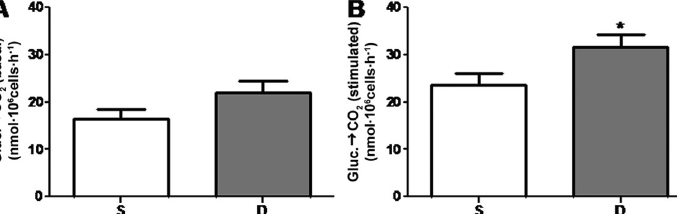
Figure 2. 14 CO 2 released from D-[U- 14 C]-glucose in isolated adipocytes. Panels A and B represent the 14 CO 14 C]-glucose 2 production from oxidized D-[U- (Gluc.) by 10 6 adipocytes isolated from the periepidi- dymal fat of animals from the sedentary (S) and detrained (D) groups. A , Basal responses, and B , responses in the presence of insulin. *P o 0.05, group S compared to group D (Student ’ s t -test, n =